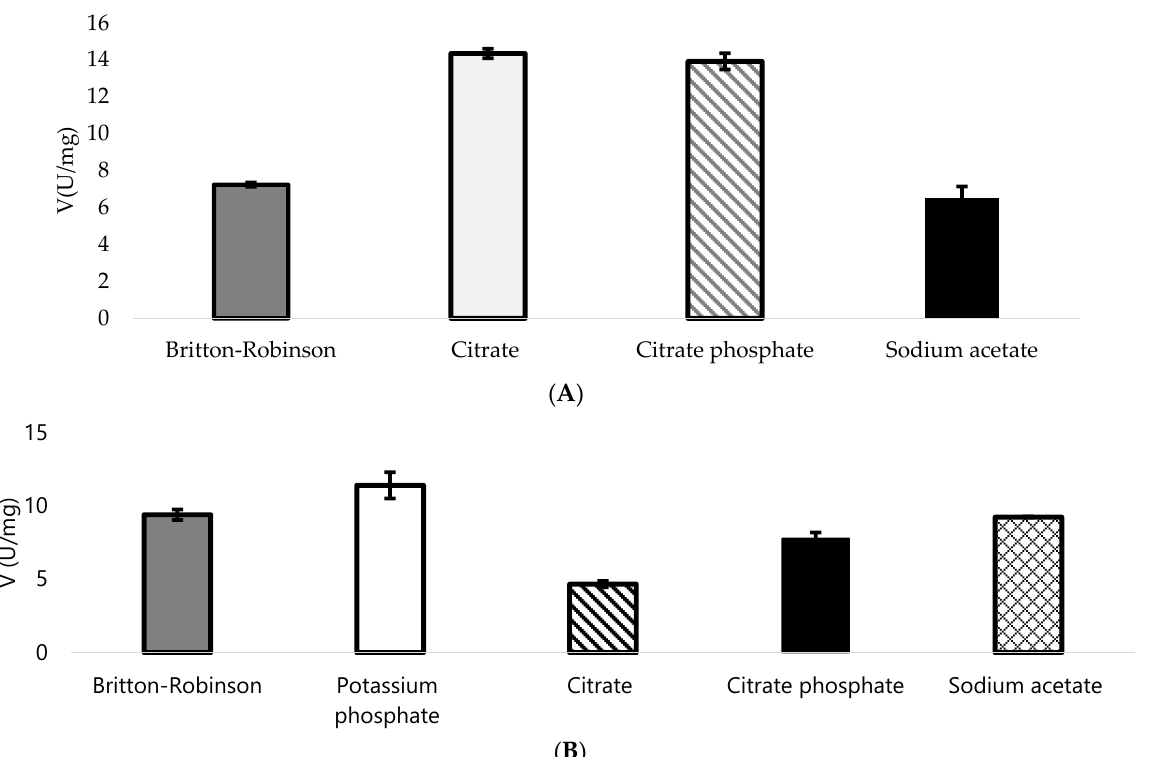
Figure 3. Specific activity of ( A ) DypA and ( B ) DypB with 1 mM ABTS as the substrate and 0.25 mM H 2 O 2 using Britton- Robinson buffer with pH ranges from pH 2 to 6 to check the optimal pH for each enzyme.